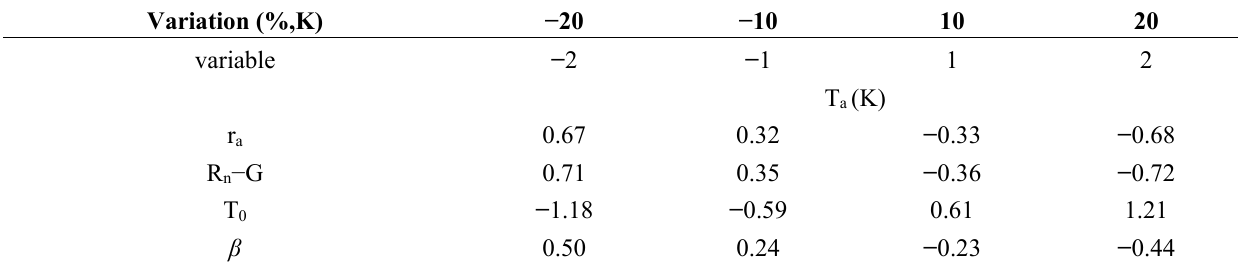
Table 4. The sensitivity of T a estimates from the ADEBAT method to each input variable. Variations of T 0 are in K, and variations of other variables are a percentage (%).